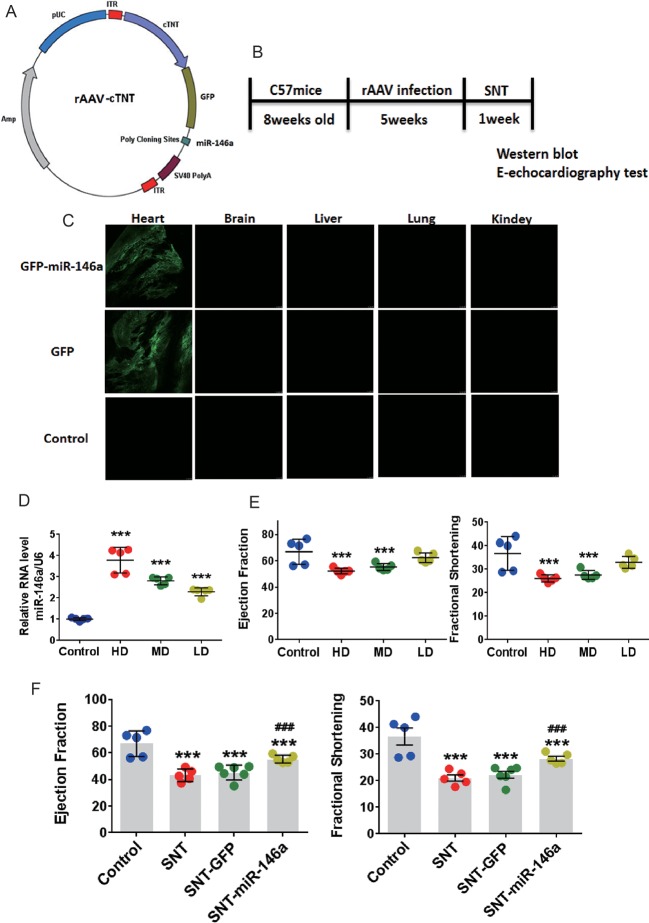
Overexpression of miR-146a attenuated cardiac contractile dysfunction induced by SNT in vivo. (A) Schematic view of AAV-9 designed to overexpress miR-146a. (B) Schedule for in vivo animal study. (C) Fluorescence intensity of GFP in different tissue sections captured by a fluorescence microscope (1×1011 viral particles). (D) MiR-146a levels after injection of different doses of AAV (HD, 10×1011; MD, 5×1011; LD, 1×1011 viral particles). (E) Echocardiography detection after injection of different dose virus. (F) Echocardiography detection after different treatments. ***P < 0.001 vs Control; ###P < 0.001 vs SNT-GFP.